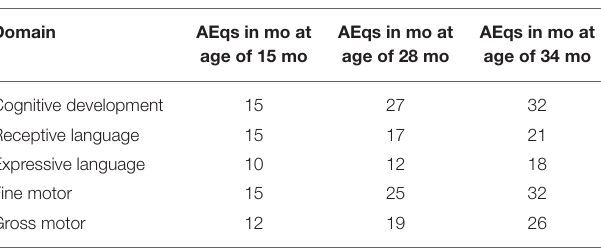
TABLE 1 | Neurocognitive and motor development